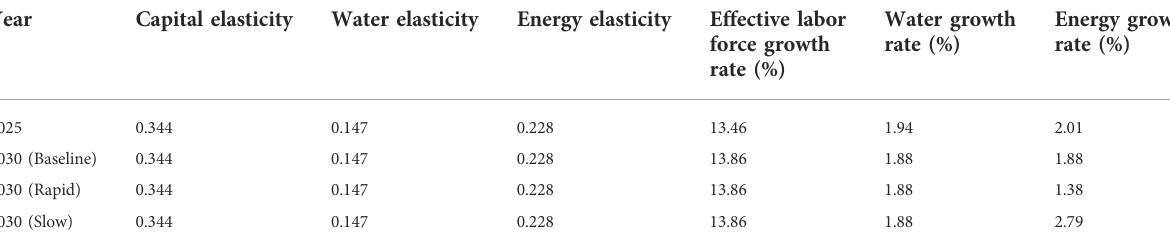
TABLE 3 Variable